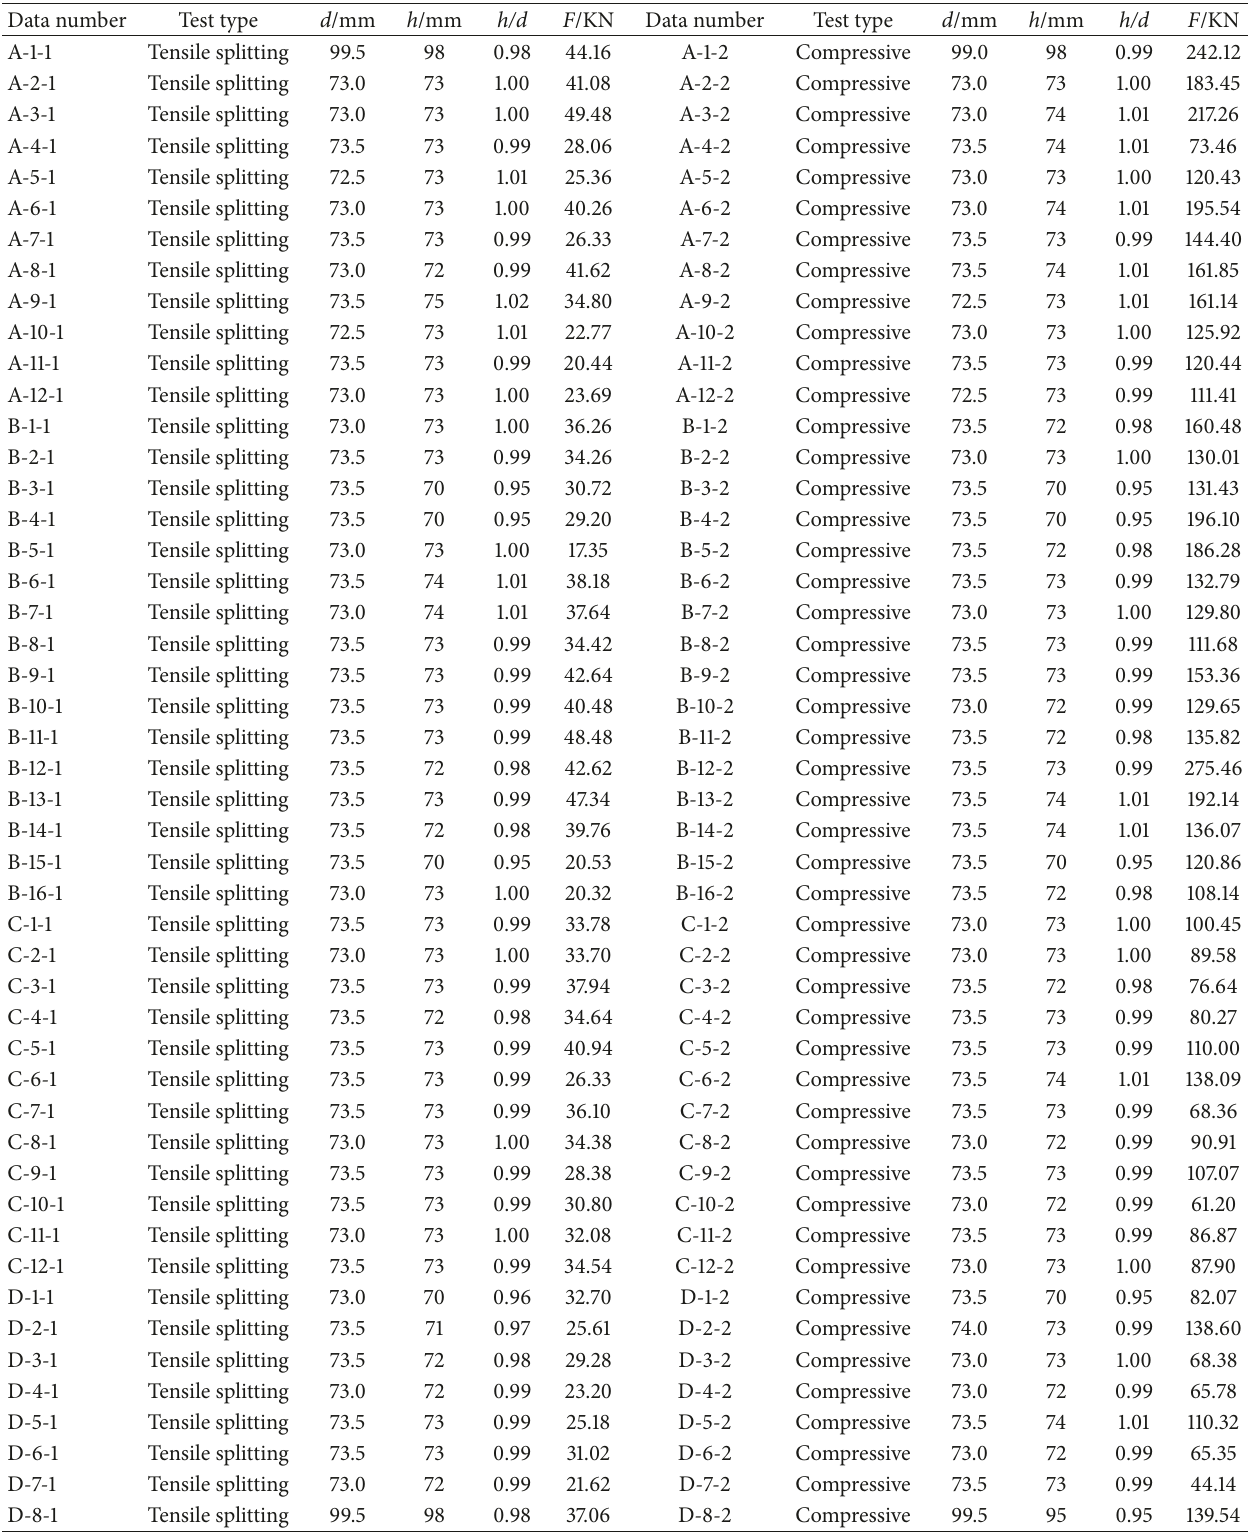
Table 2: The primary data of